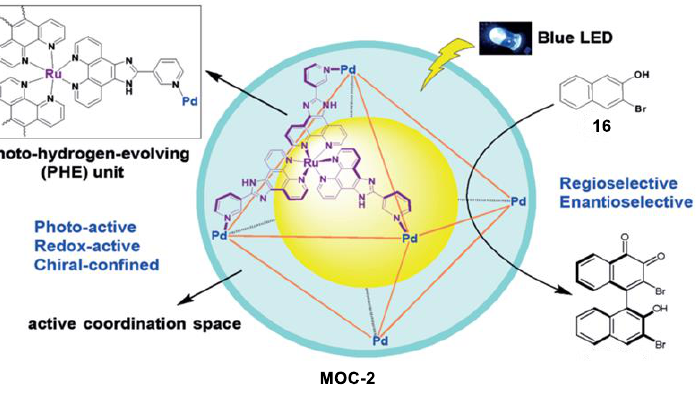
Figure 12. Oxidative coupling of 2-naphthol catalyzed by MOC-2 [76]. Reaction additions: 16 (2.5 × 10 − 3 mmol), MOC-2 (10 mol%), 8 W blue LEDs ( λ max = 453 nm), CH 3 CN/H 2 O, r.t. Reprinted/adapted with permission from Ref. [76]. Copyright 2017 Wiley VCH.